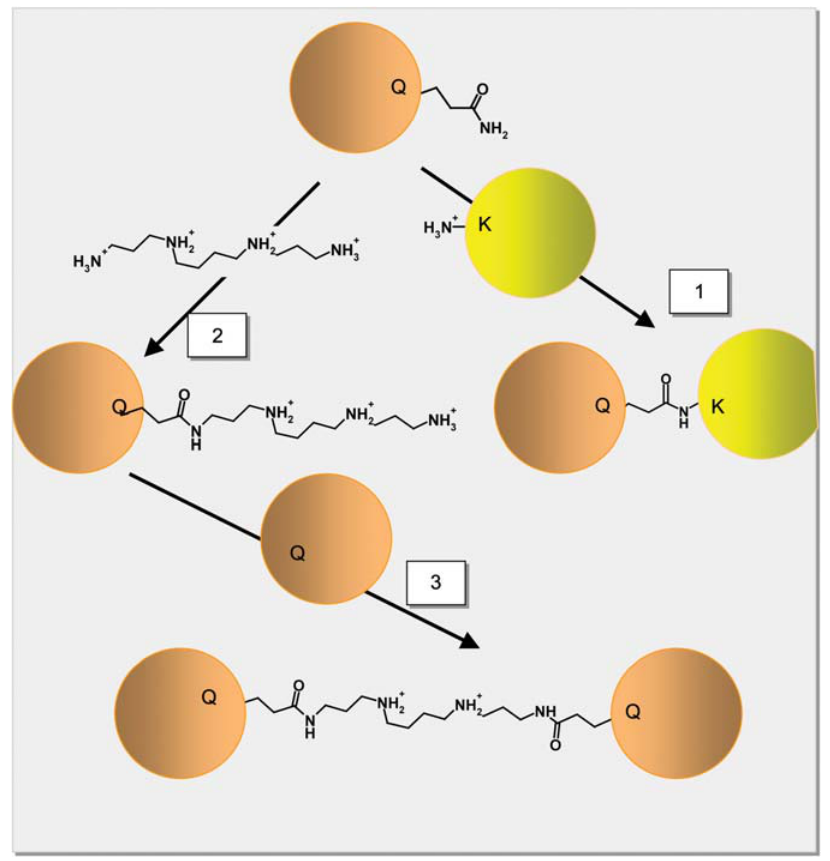
Figure 3 Covalent binding of polyamines on protein surfaces catalyzed by transglutaminases. Transglutaminases crosslink proteins by transamidating the g -carboxamide group of glutamine residues (Q) on one protein with ´ -amino groups of lysines (K) on a different protein (1). Polyamines (here spermine) can substitute for lysines, first resulting in a covalently modified protein with increased positive charge (2); in a next step transamidation of a g -carboxamide on a different protein leads to an aggregate with a flexible, charged linker